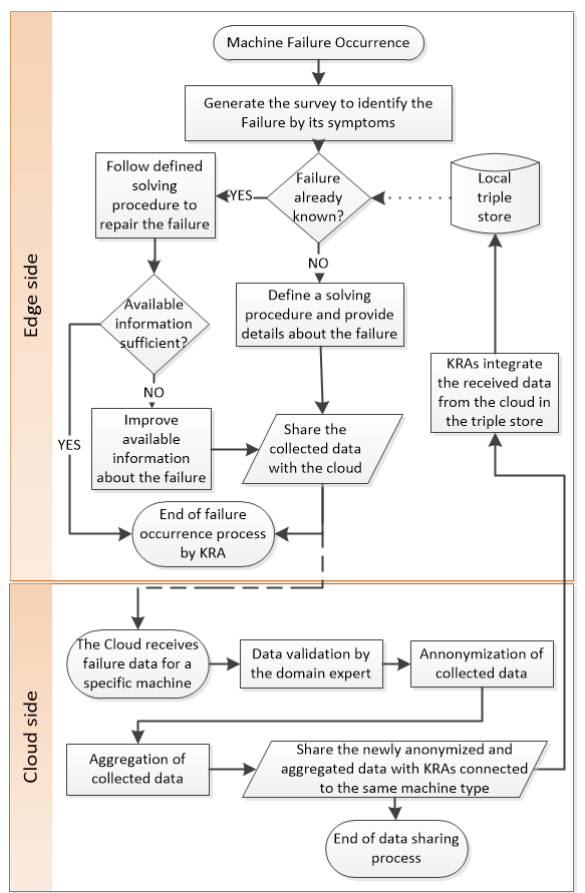
Figure 5. SemKoRe